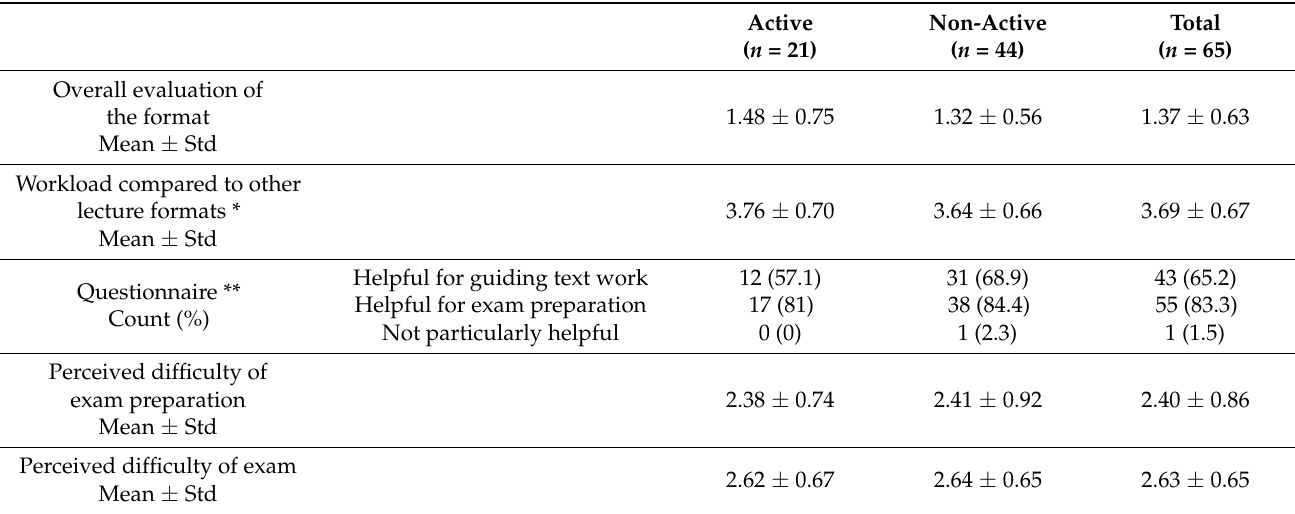
Table 1. Students’ evaluation of the Interactive Literature Lecturing Format (ILLF): Comparison between active and non-active